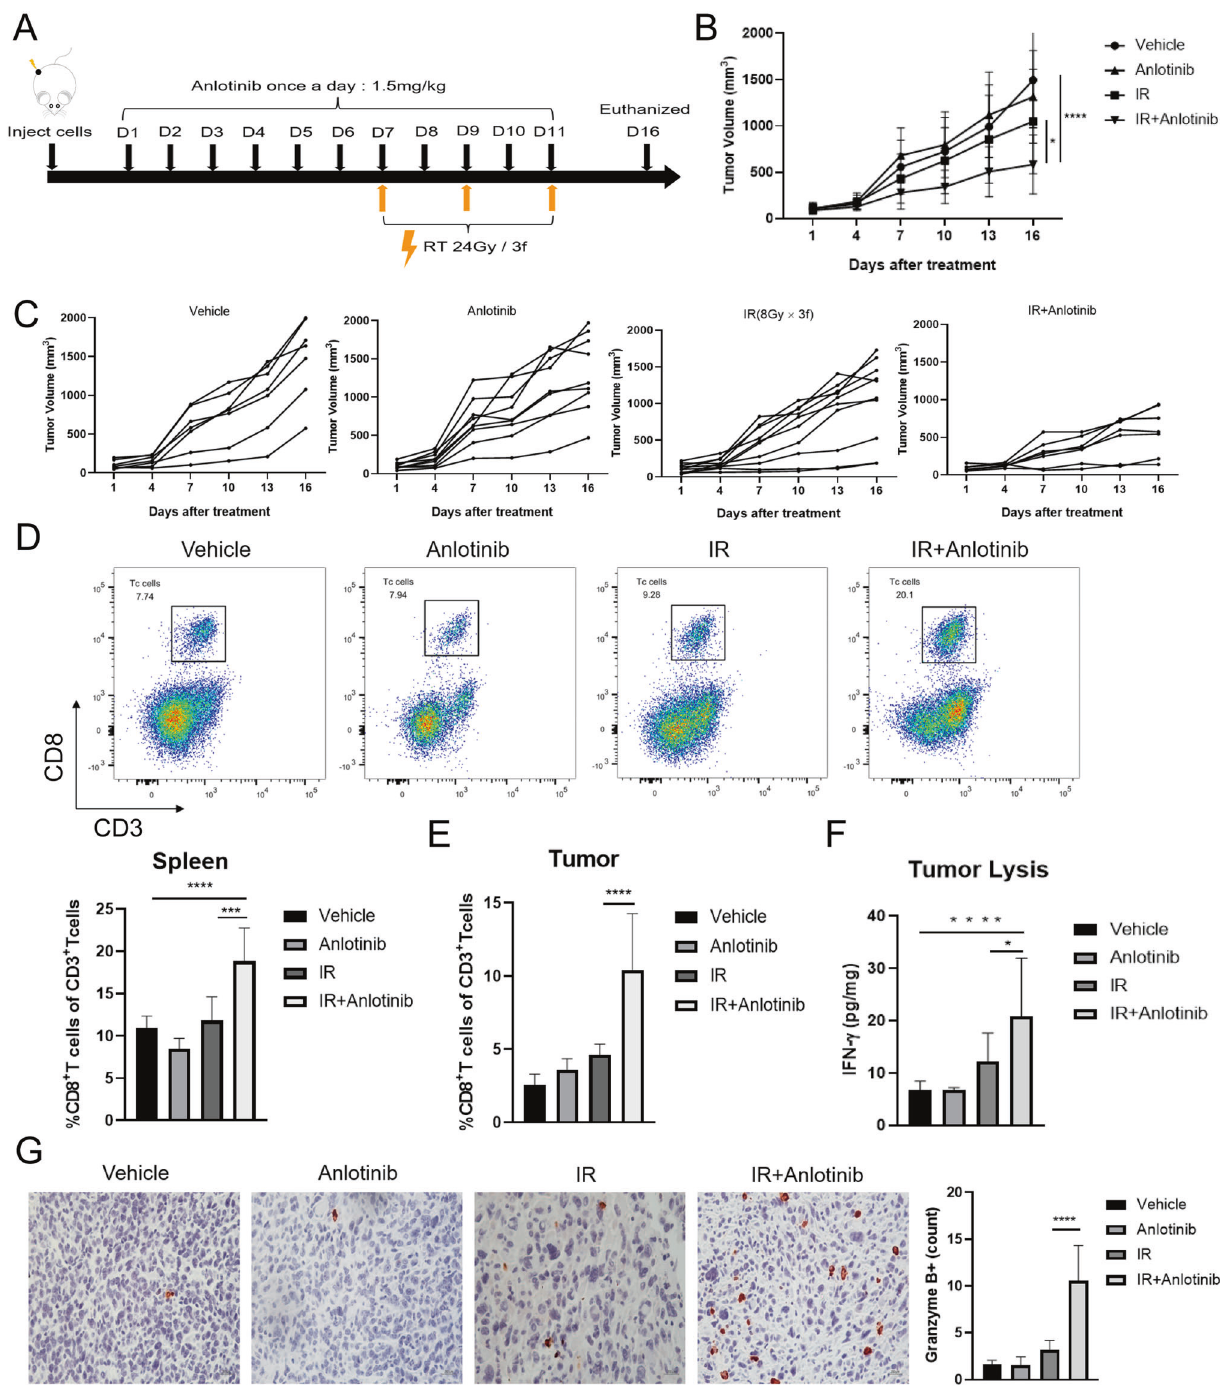
Fig. 3 Anlotinib combined with IR increases CD8 + T cell recruitment. A Schematic illustration of treatment schedule for LLC-OVA tumor- bearing mice. B When the tumor volume reached an average of 100 mm 3 , the mice were randomly divided into different treatment groups, and tumor volume was measured every 3 days. Two-way ANOVA with Tukey ’ s multiple comparison. C Individual growth curves for the subcutaneous tumor in each group (Vehicle, n = 7; Anlotinib, n = 9; IR, n = 10; IR + Anlotinib, n = 7). D Representative fl ow cytometry staining (upper panel) and quanti fi cation of percentage (lower panel) of CD8 + T cells in spleen on day 16 after treatment initiation (Vehicle, n = 8; Anlotinib, n = 8; IR, n = 5; IR + Anlotinib, n = 7). One-way ANOVA with Tukey ’ s multiple comparison. E Percentage of CD8 + T cells in tumor on day 16 after treatment initiation (Vehicle, n = 9; Anlotinib, n = 8; IR, n = 6; IR + Anlotinib, n = 7). One-way ANOVA with Tukey ’ s multiple comparison. F Intratumoral IFN- γ concentrations were measured using Elisa. Relative IFN- γ level was calculated by normalizing to protein concentration of each sample. One-way ANOVA with Tukey ’ s multiple comparison. G Representative immunostaining images and quanti fi cation of GzmB in subcutaneous tumors were assessed with IHC. Scale bar, 200 μ m. One-way ANOVA with Tukey ’ s multiple comparison. Data are presented as the mean ± standard deviation, * p < 0.05, ** p < 0.01, *** p < 0.001, **** p <